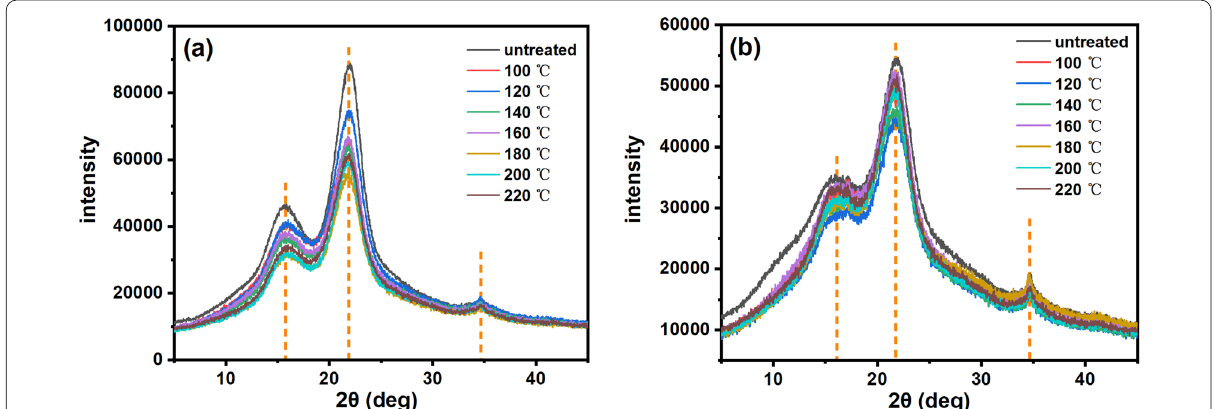
Fig. 8 XRD patterns of cellulose in a fibers and b parenchyma cells with heat treatments